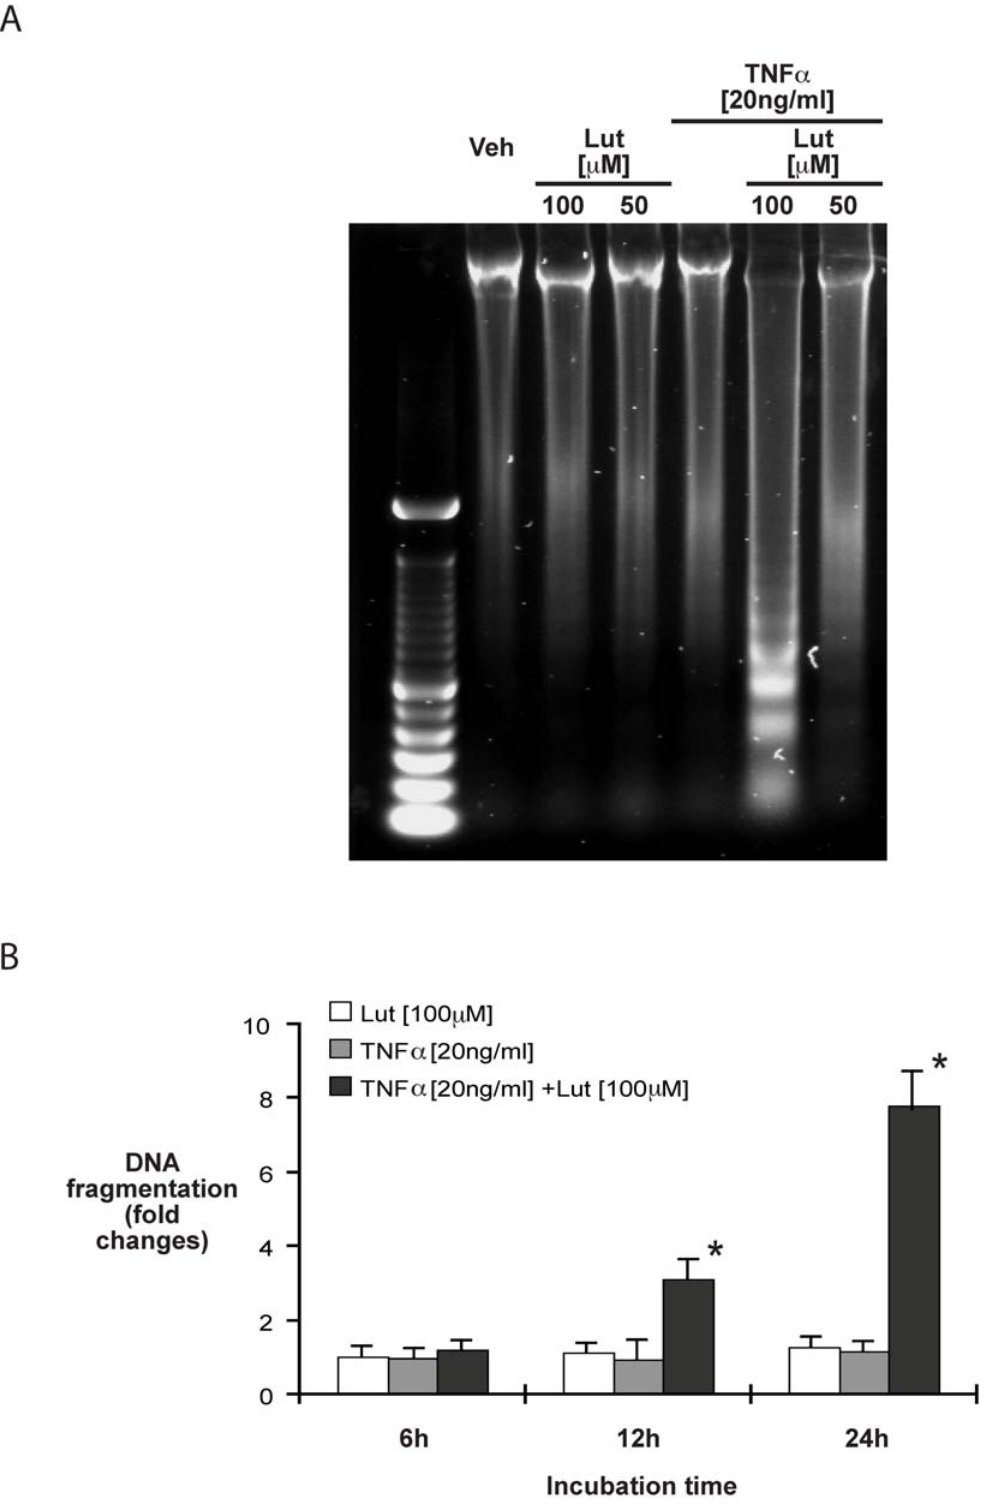
Figure 6. Luteolin-treatment sensitizes TNF a -exposed HT29 cells to DNA fragmentation and cytoplasmic accumulation of oligonucleosome- bound DNA. HT29 cells were pretreated with various concentration of luteolin alone or in combination with TNF a (20 ng/ml) for 24 h. Cells were lysed, DNA extracted and separated on a 1% agarose gel. Results are representative of three independent experiments (A). HT29 cells were treated as described above for 12 and 24 h. Cells were lysed and apoptosis measured using an ELISA-based assay as described in the Method section. Representative results of at least 3 independent experiments are shown (* p , 0.01 versus TNF a alone) (B).